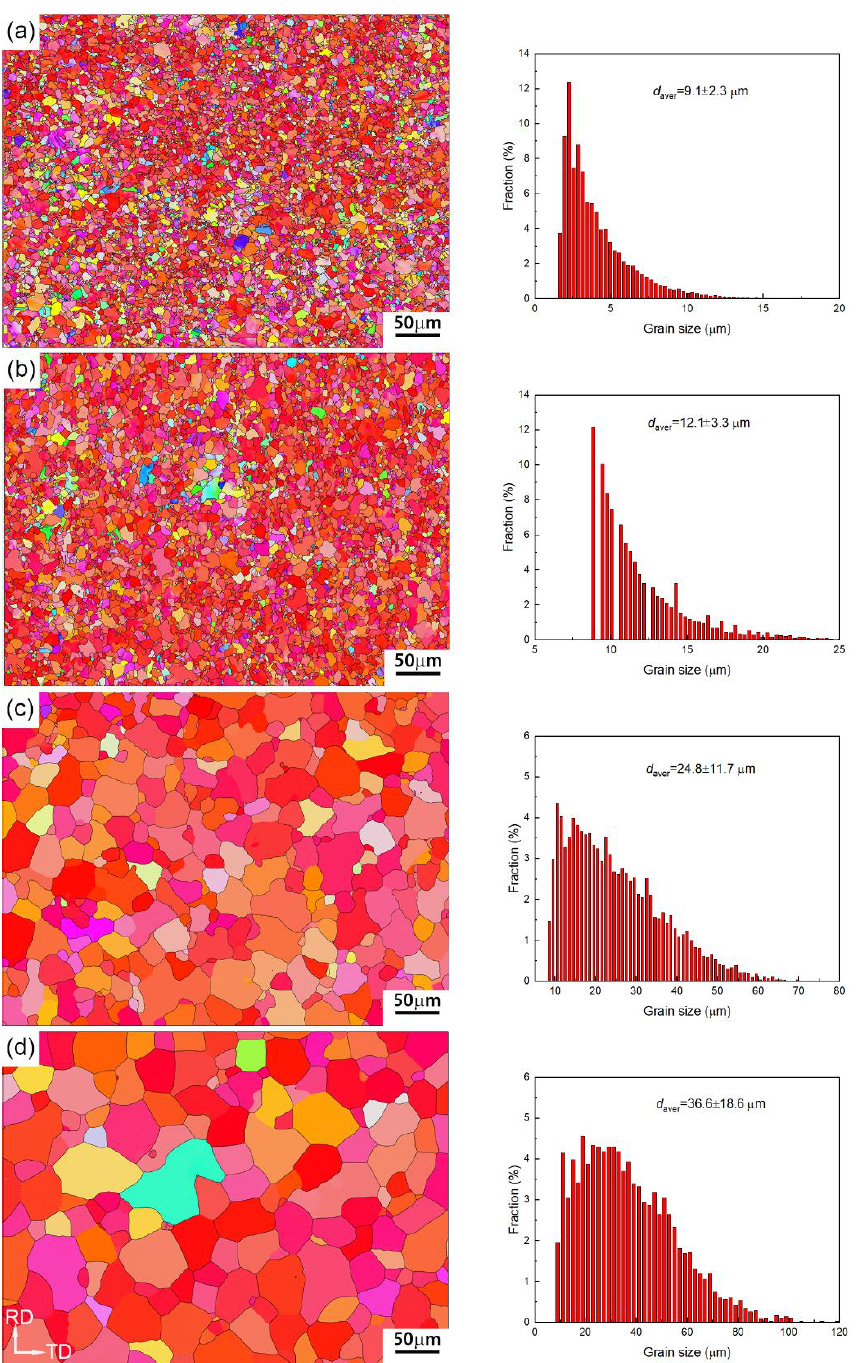
Figure 6. Inverse pole figure (IPF) maps on the ND plane of the Mg-6Al alloy plates ( on the left ) and corresponding grain size distributions ( on the right ) for the conditions: ( a ) as-rolled, with the same plate annealed: ( b ) 250 °C, ( c ) 275 °C, and ( d ) 300 °C for a fixed time of 15 min.